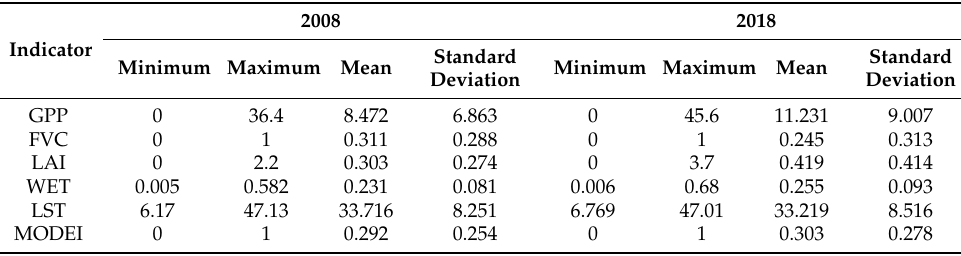
Table 3. MODEI and related indicator values of 2008 and 2018.